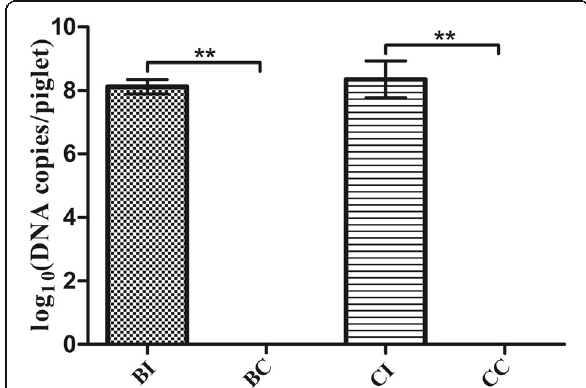
Fig. 6 Quantitative PCR assay of M. hyopneumoniae from the BALF of all pigs. Primers and TaqMan-BHQ probes were designed based on the conserved sequence of the P97 gene of M. hyopneumoniae . BAL fluids from all piglets were collected, and the log 10 DNA copy number per piglet distribution against P97 was quantified using quantitative real- time PCR. **, P <0.01, indicates that DNA copy numbers of each piglet in both Bama miniature pigs and conventional pigs of the M. hyopneumoniae strain JS-infected groups were significantly higher than those in the two control groups, respectively. Dates are expressed as the mean±SD form the infected groups of Bama miniature pigs (BI) and conventional pigs